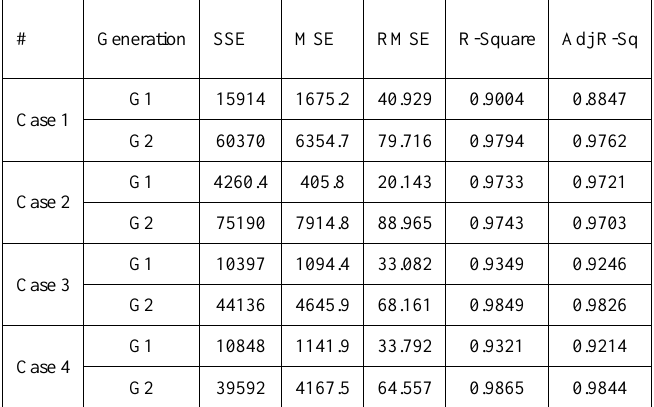
Table 3. Comparison criteria for all cases